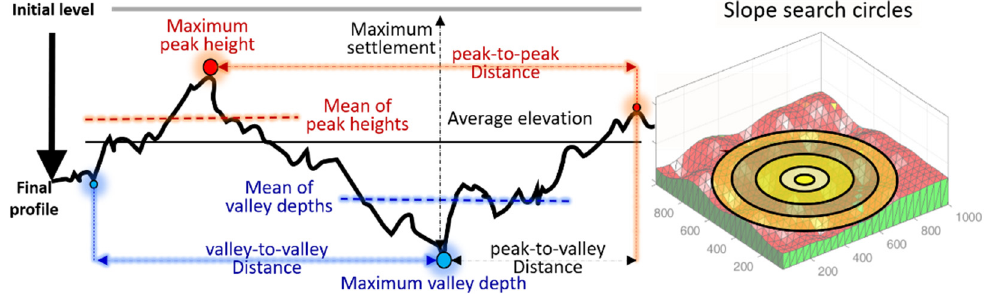
Figure 3. Differential settlement metrics.